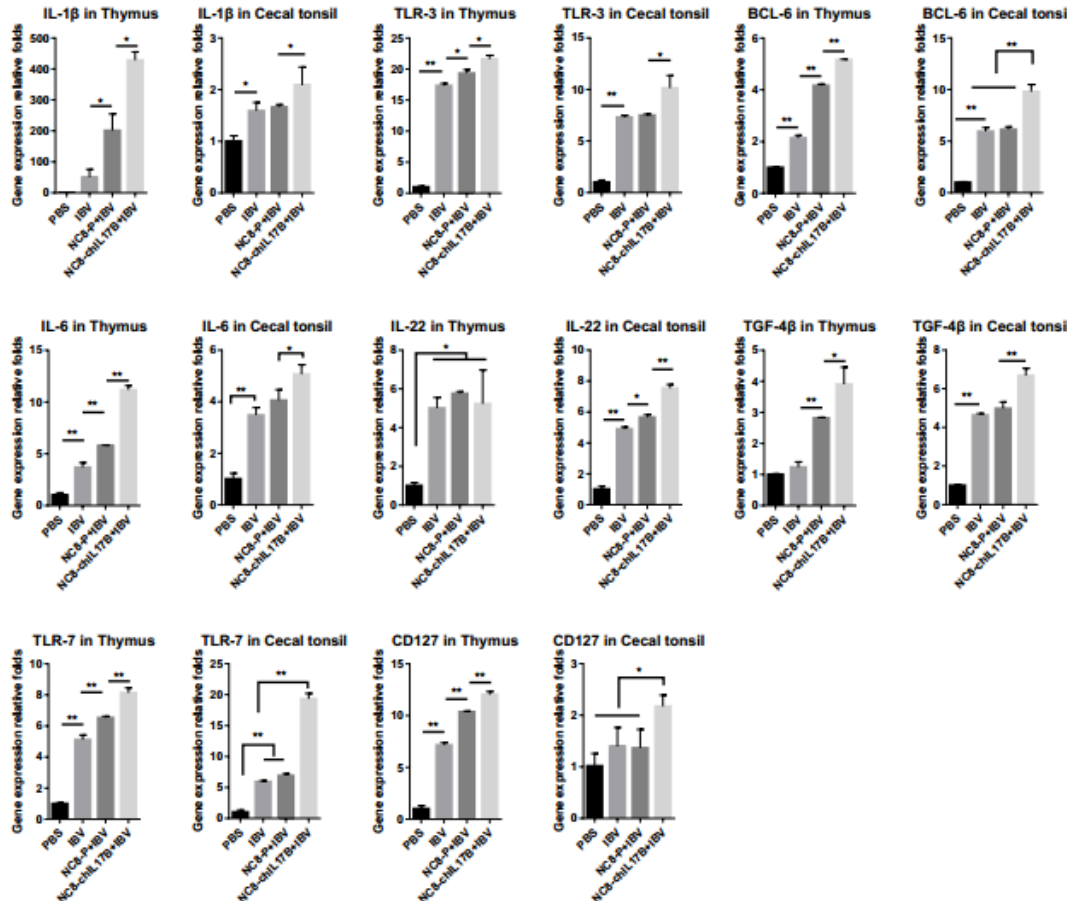
Figure 7. Expression of several immune genes in the thymus and the cecal tonsils. IL-1 β : Interleukin-1 β ; TLR-3: Toll-like receptor 3; BCL-6: B-cell CLL/lymphoma 6; IL-6: Interleukin-6; TGF- β 4: transforming growth factor- β 4, TLR-7: Toll-like receptor 7; CD127: cluster of differentiation. Tukey's multiple comparison test was used for statistical analysis; * p < 0.05, ** p < 0.01.